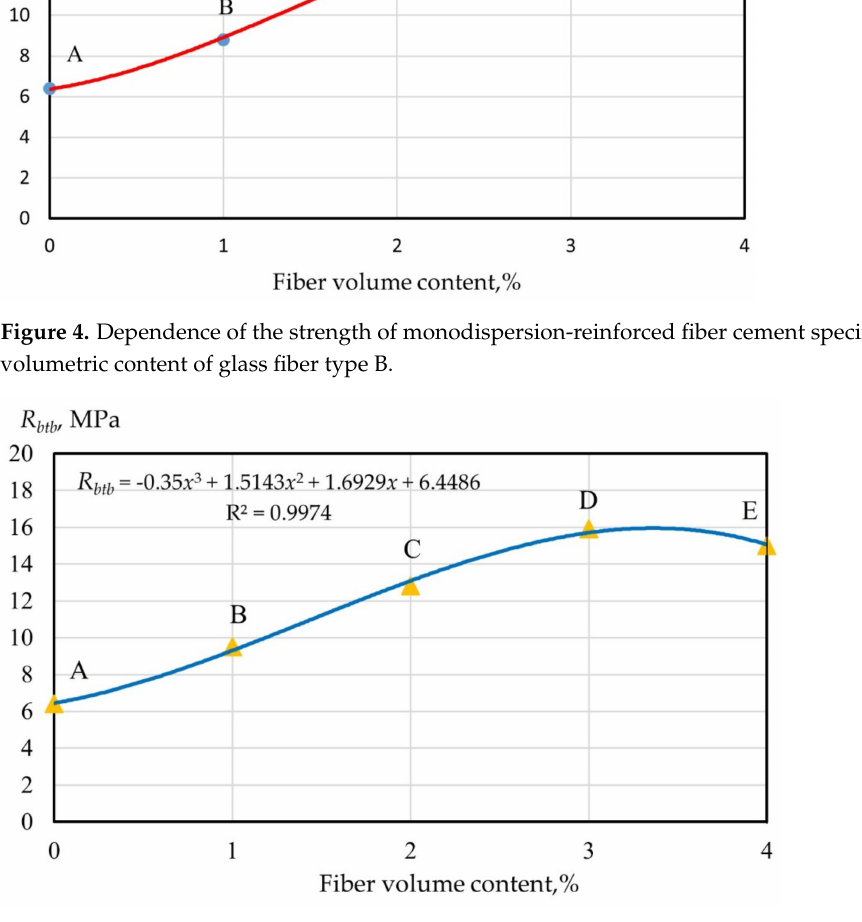
Figure 5. Dependence of the strength of polydispersion fiber-reinforced concrete depending on the volumetric content of glass